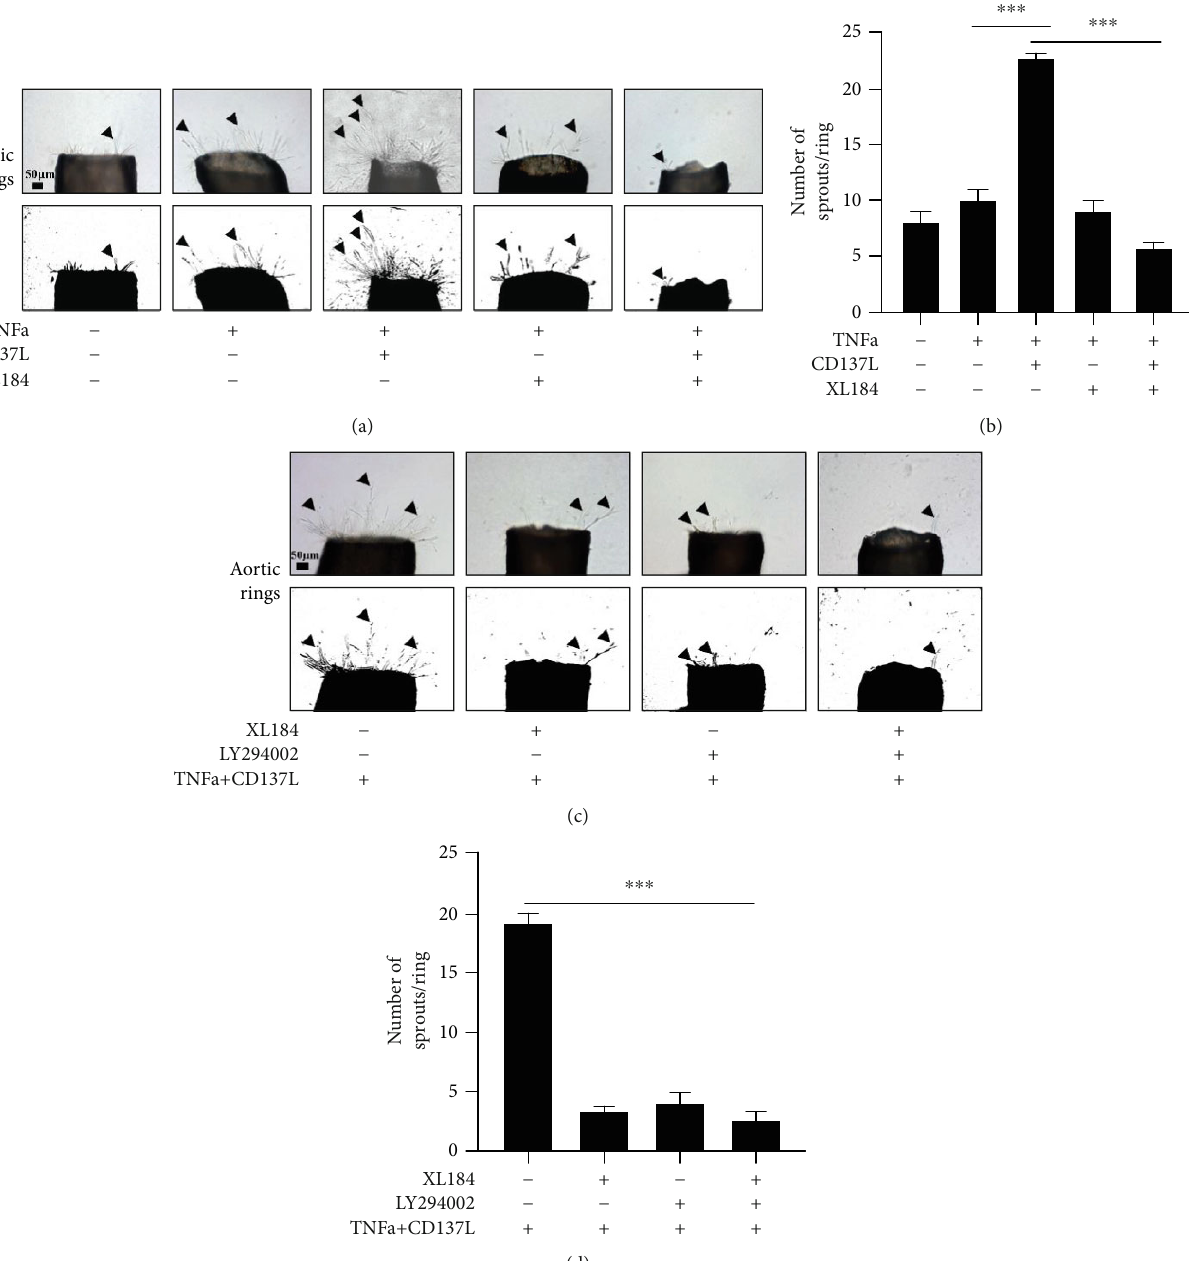
Figure 5: CD137-enhanced aortic sprouting and outspreading through the VEGFR2/Akt/eNOS pathway. (a) The sprouting of aortic rings under the CD137 activation or/and inhibition of VEGFR2 with XL184 (cabozantinib). (b) Number of sprouts per ring was quanti fi ed by Image-Pro Plus 8.0, scalebar = 50 μ m . (c) Aortic rings sprouting after treatment with VEGFR2 siRNA or/and LY294002 under the CD137 activation. (d) Number of sprouts per ring was quanti fi ed by Image-Pro Plus 8.0, scale bar = 50 μ m . ∗∗∗ p < 0 : 001 , n = 5